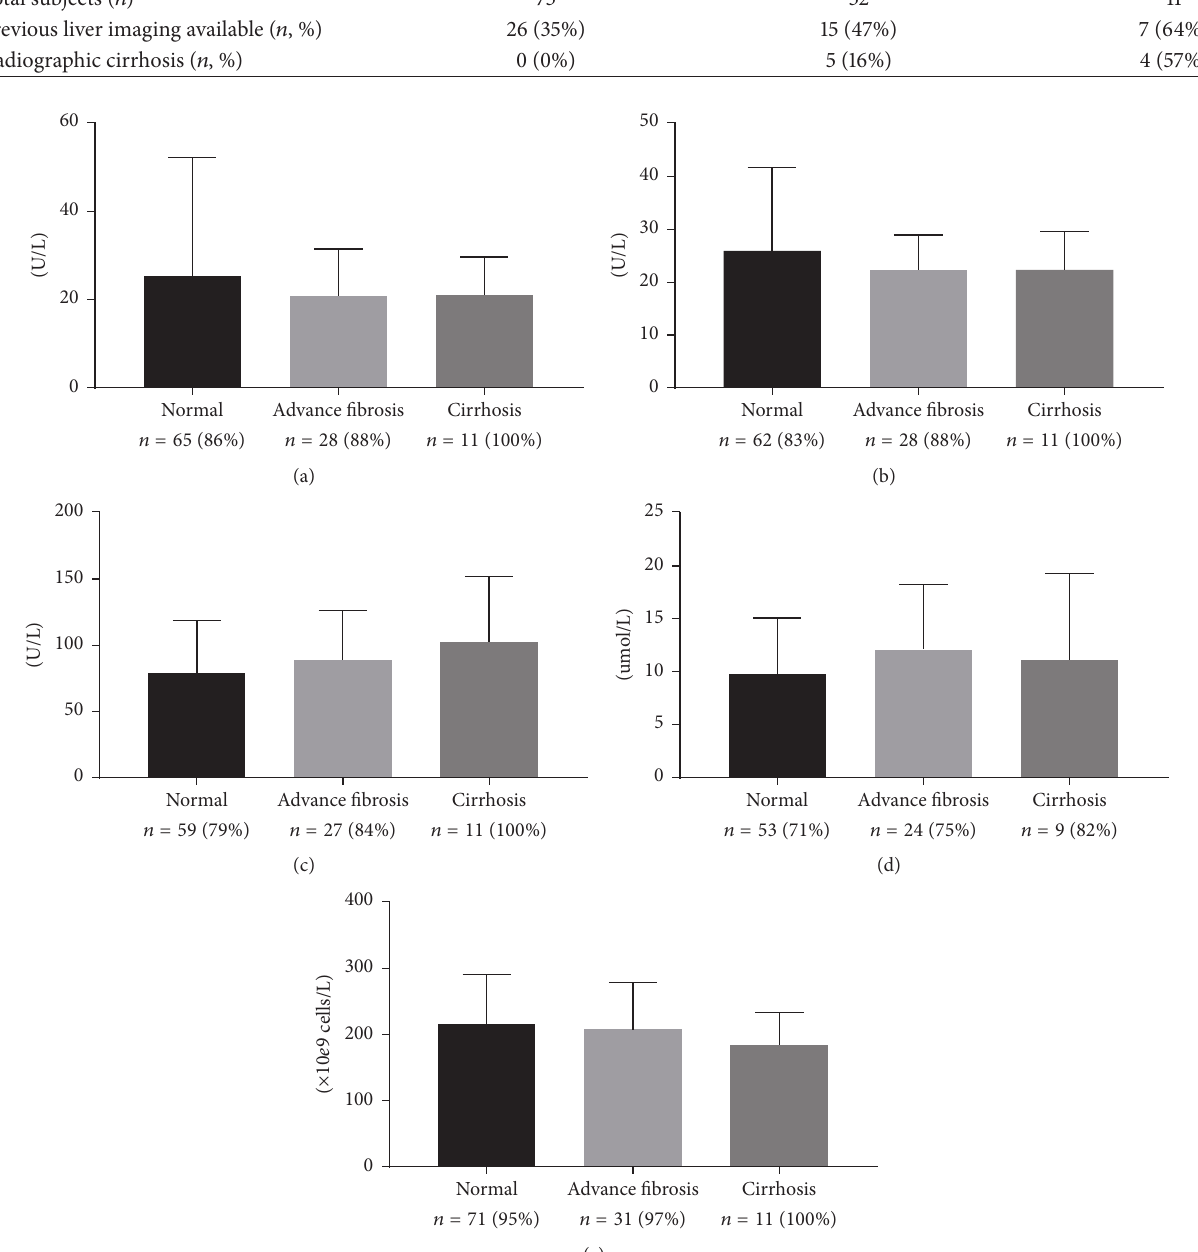
Figure2:Insubjects 𝑛 (%ofgroup)withpreviouslaboratoryinvestigationsavailable,nosignificantdifferencein(a)alanineaminotransferase, (b) alanine aspartate aminotransferase, (c) alkaline phosphatase, (d) total bilirubin, or (e) platelet count was detected in subjects with elevated liver stiffness measurement (cirrhosis versus normal, Mann–Whitney tests, 𝑃 > 0.05